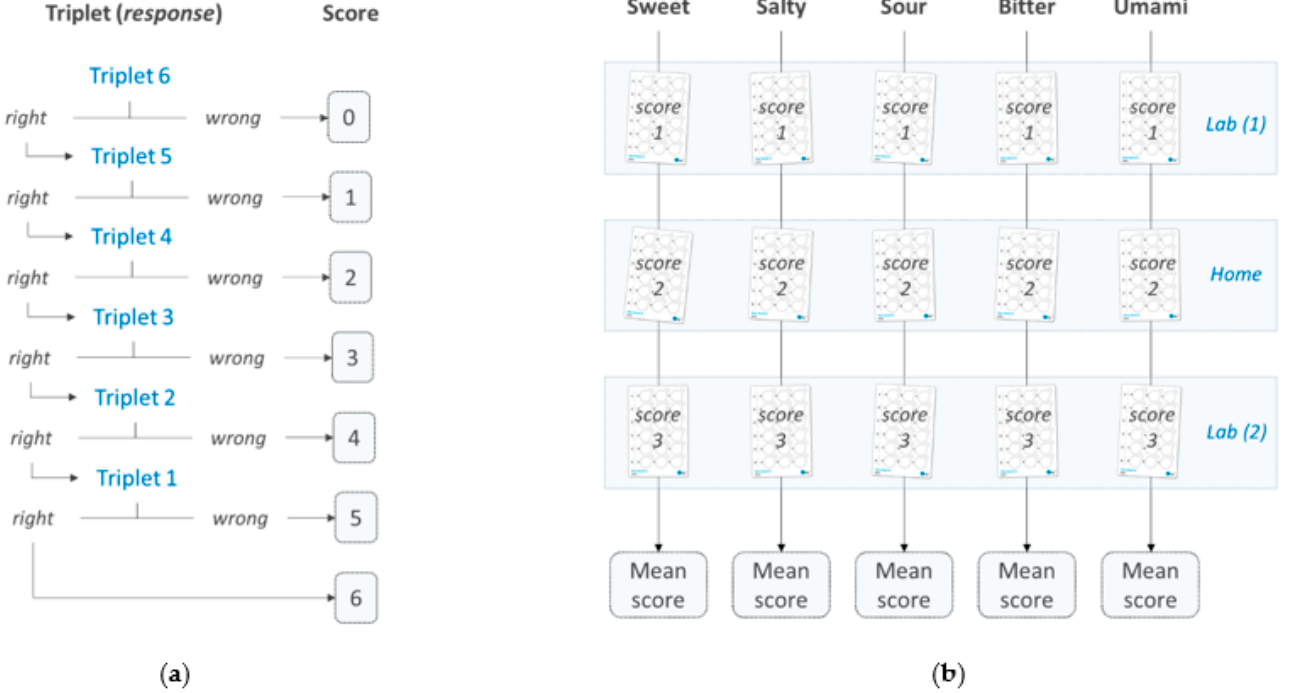
Figure 3. ( a ) Determination of the sensitivity score (for a given test sheet). The score was based on the greatest sequence of correct answers, starting from the sixth triplet of discs (highest concentration). ( b ) For each taste, three measurements were performed, each giving rise to a sensitivity score. The average of the three scores was used to determine the sensitivity of the subjects.